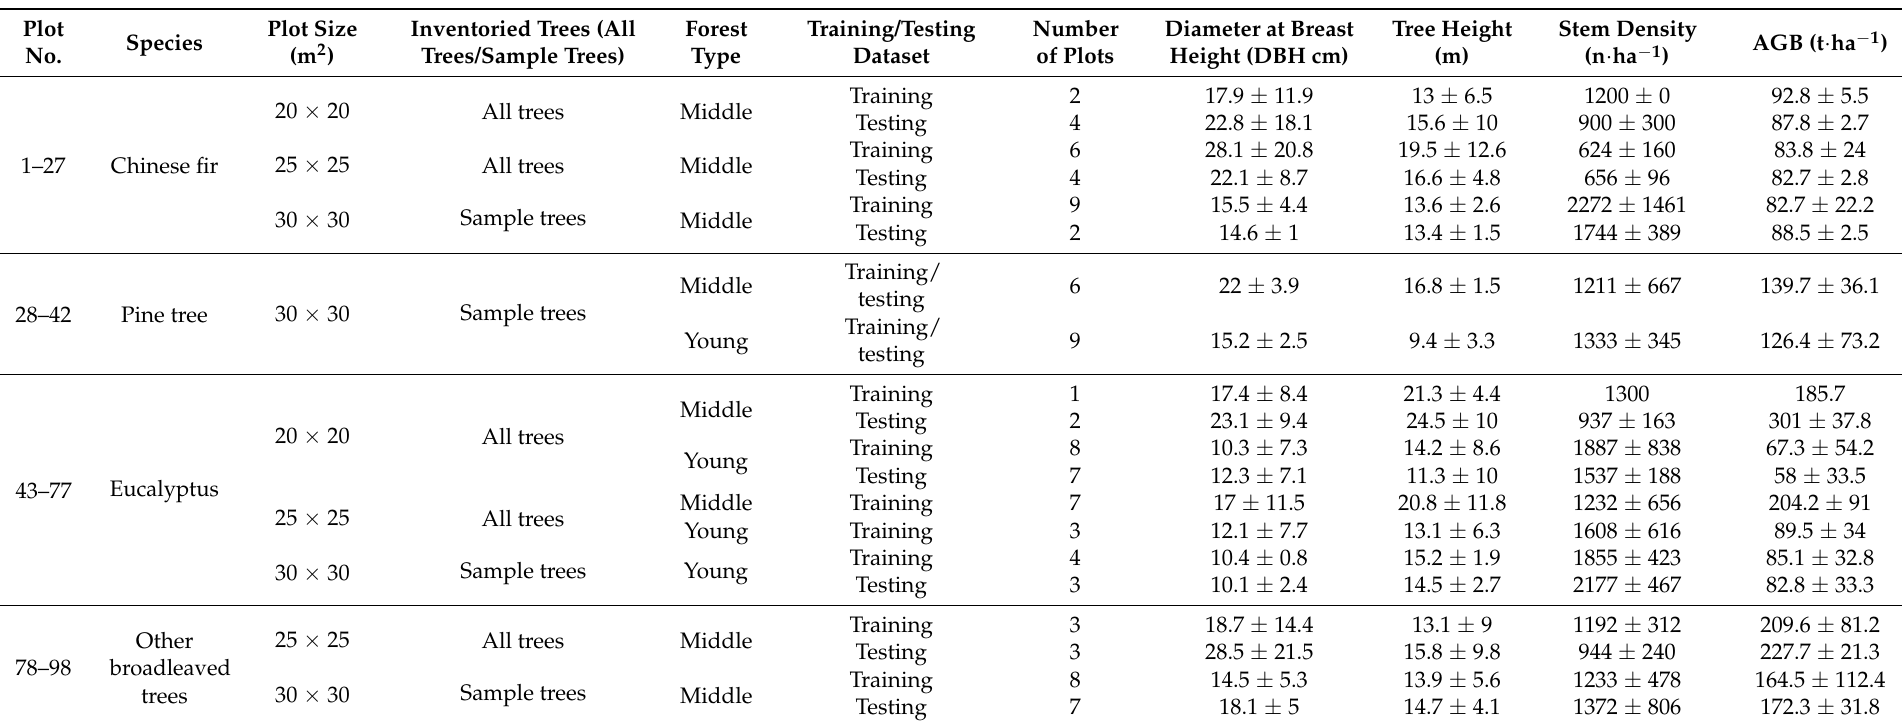
Table 1. Sample plots